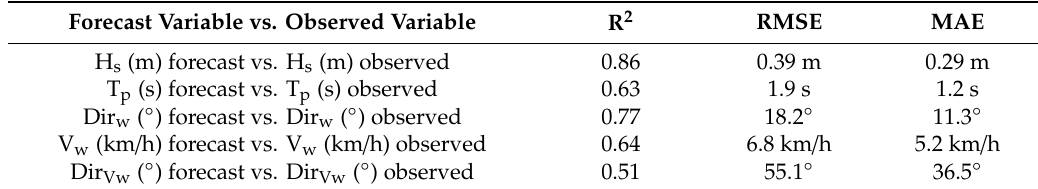
Table 2. Coefficient of determination (R 2 ), root mean square error (RMSE) and mean absolute error (MAE) of forecast and observed meteorological and ocean variables.